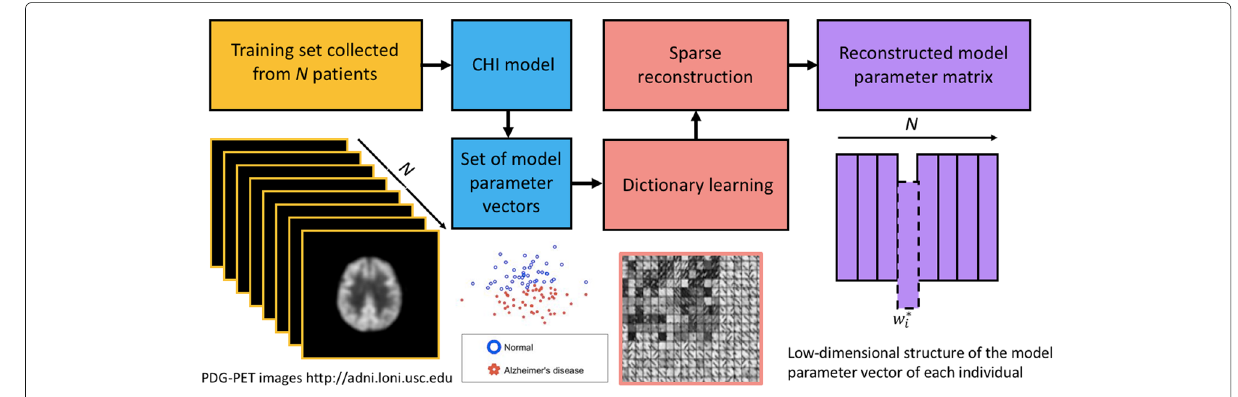
Fig. 1 A conceptual overview of the DL-CHI method